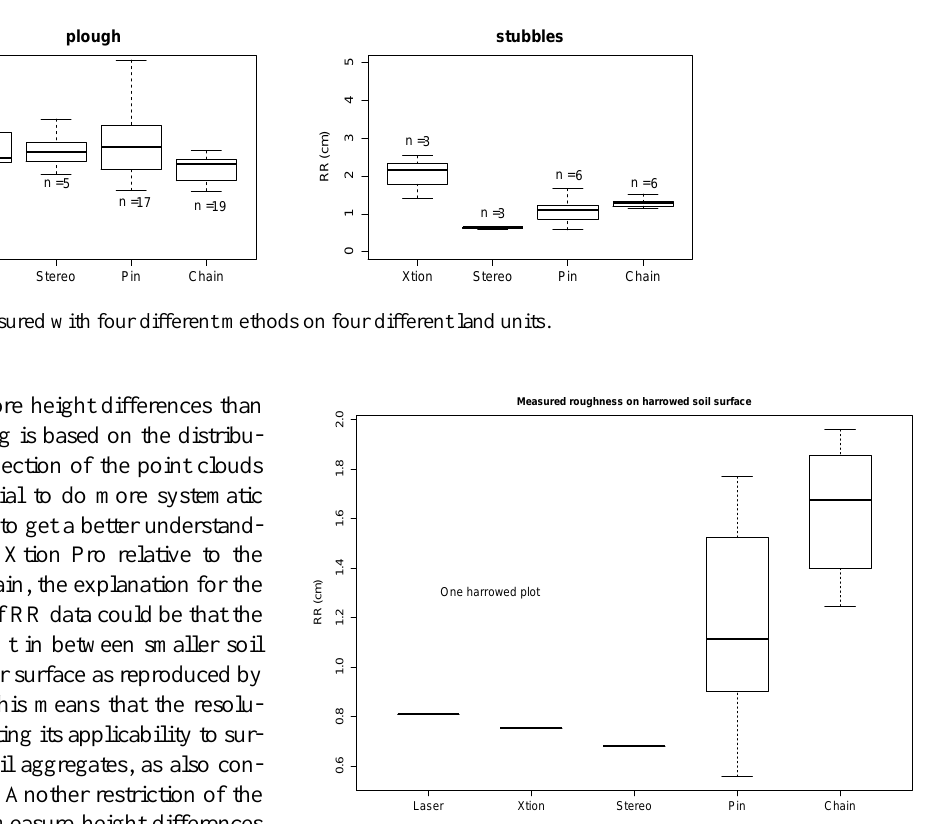
Figure 5. Random roughness (RR) values for one harrowed plot based on five different measurement